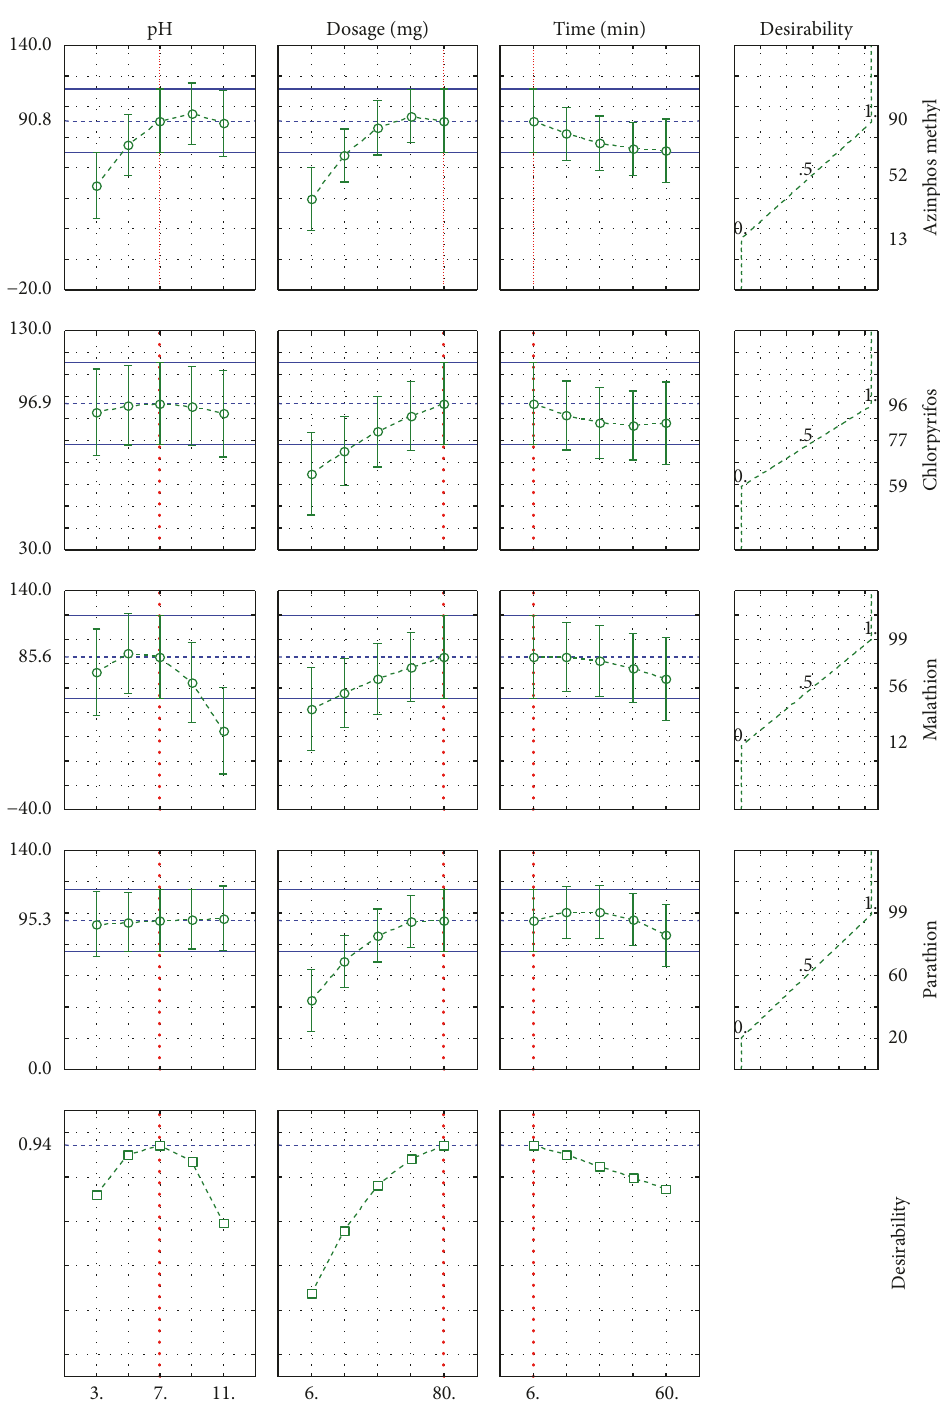
Figure 7: Profiles for predicated values and desirability function for extraction of azinphos methyl, chlorpyrifos, malathion, and parathion mix. Dashed line indicated current values after